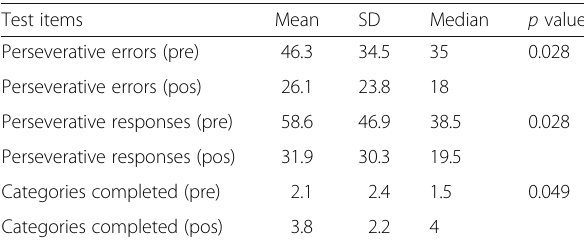
Table 4 Differences in perseverative errors, responses, and categories completed comparing pre- and